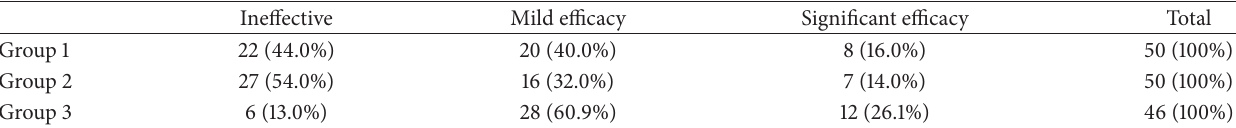
Figure 2: Changes in liver enzymes and lipid parameters over the 24-week treatment period (histogram). ∗ ∗ ∗ refer to 𝑃 < 0.001 for comparisons within metformin group. + + + refer to 𝑃 < 0.001 for comparisons within DGEC group. ### refer to 𝑃 < 0.001 for comparisons within drug combination group. ∗ refers to 𝑃 < 0.05 for comparisons within metformin group. ++ refer to 𝑃 < 0.01 for comparisons within DGEC group. + refer to 𝑃 < 0.05 for comparisons within DGEC group. Table 5: Therapeutic effectiveness in the three